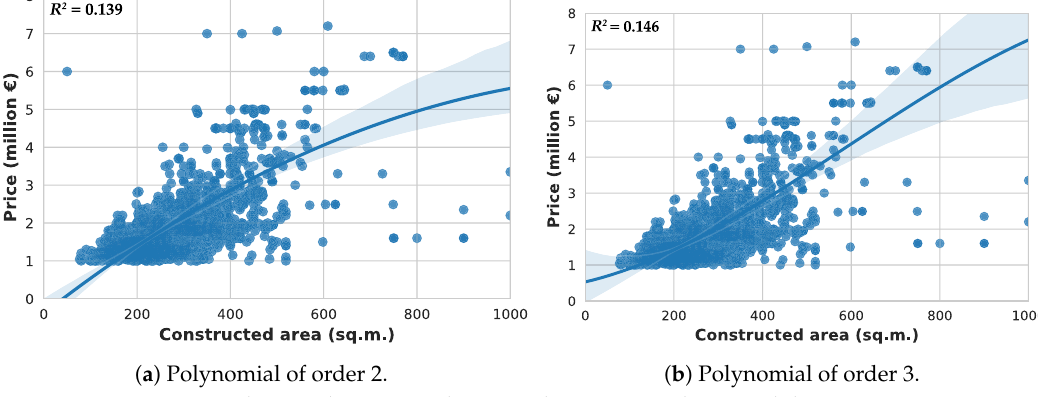
Figure 8. Polynomial regression between the constructed area and the asset price. Table 2. Ordinary least squares estimations—in Column 1 “non-robust” estimation. Column 2 represents a “robust” estimation (HC0) following White [16], price in millions. Stars indicate p